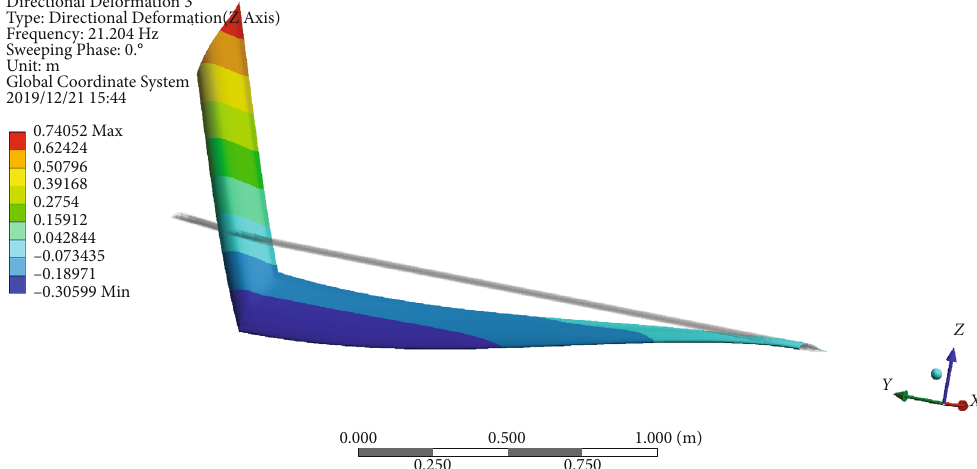
Figure 15: Flap/torsion coupled mode.